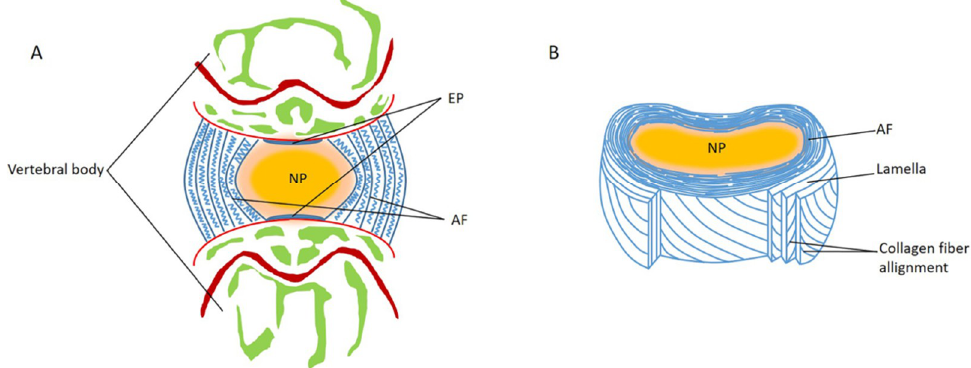
Figure 1. Schematic representations of the adult intervertebral disc (IVD). ( A ) Midsagittal cross-section showing anatomical regions. ( B ) Three-dimensional view of the annulus fibrosus (AF) lamellar structure.